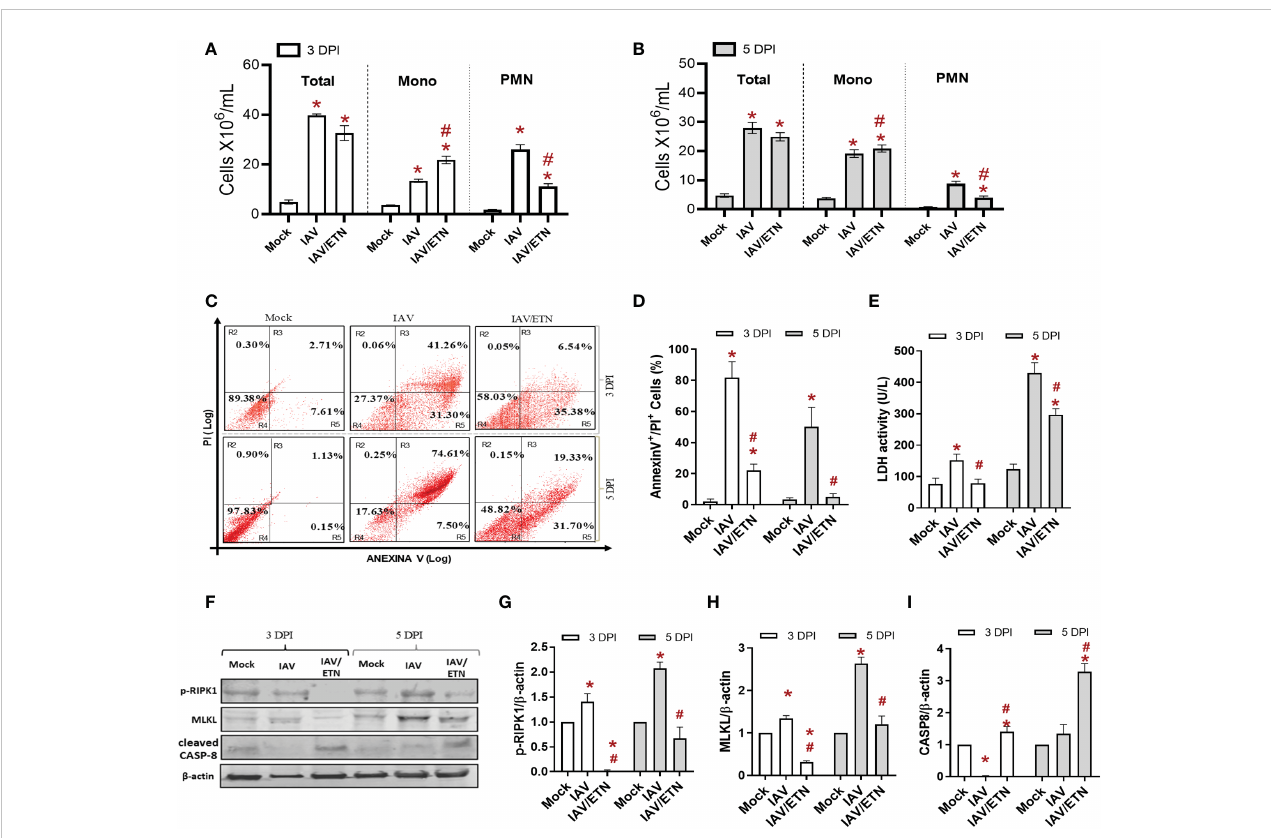
FIGURE 5 Etanercept reduced in fl ammatory programmed cell death in macrophages in vivo . C57Bl/6 mice were inoculated intranasally with 10 3 PFU of IAV with and without daily treatment with Etanercep (ETN, 2.5 mg/kg, i.p.). At days 3 and 5 postinfection, animals were euthanized, and BAL and lung were collected. (A, B) Total and differential cell counts in bronchoalveolar lavage (BAL) are represented as the number of differential cell counts at days 3 (A) and 5 (B) postinfection. Total: leukocytes total, Mono: mononuclear leukocytes, PMN: polymorphonuclear leukocytes. (C, D) Mononuclear cell death was evaluated by annexin V/PI labeling. (E) Lung damage was evaluated by measuring LDH release in the bronchoalveolar lavage (BAL); (F – I) The expression of p-RIPK1, MLKL, and cleaved Caspase-8 was detected in the lung tissue homogenates by Western blotting. b -actin levels were used as a control for protein loading. (G – I) Graphs of band densitometry obtained after loading normalization and expressed as fold change over mock control. Data are expressed as the means ± SEMs; one-way ANOVA with Dunnett ’ s post hoc test. * P < 0.05 in comparison to mock and # P < 0.05 in comparison to the IAV-infected untreated group. Experiments were performed with 4-6 mice/group.